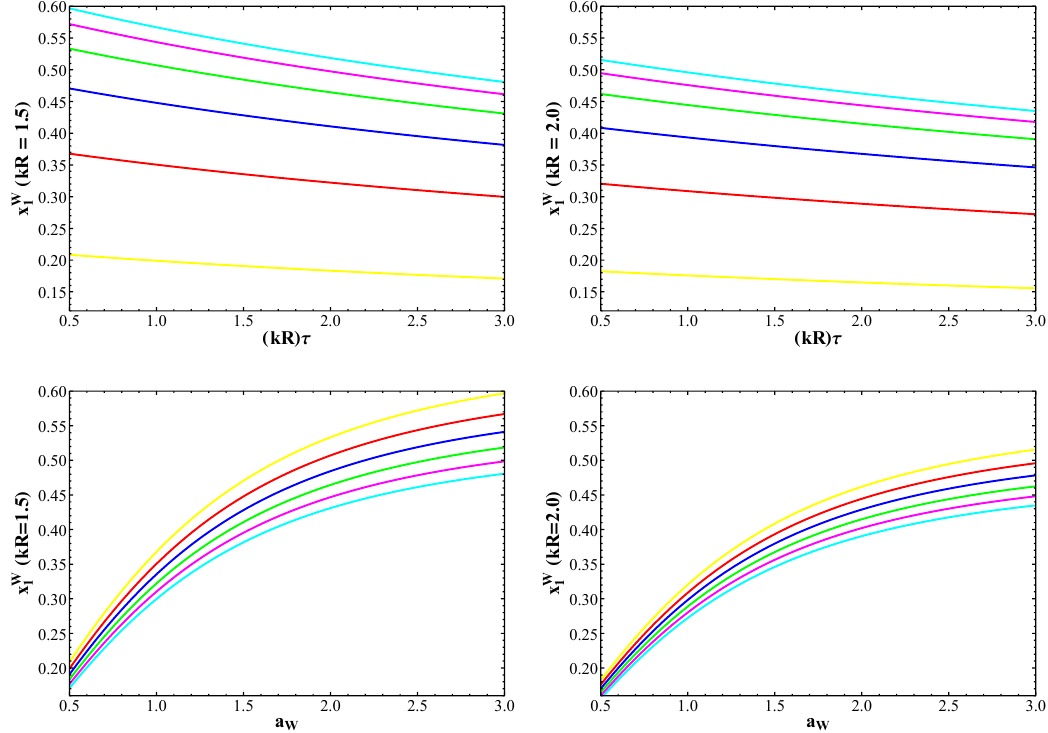
Figure 11 . (Top left) Value of the root x W assuming kR = 1 . 5 as a function of τ for various 1 choices of a W , from bottom to top, a W = 1 / 2 , 1, 3/2, 2, 5/2 and 3, respectively. (Top right) The same as the top left, but assuming kR = 2 . 0 (Bottom left) Value of the root x W assuming as a 1 function of a W for various choices of τ , from top to bottom, ( kR ) τ = 1 / 2 , 1, 3/2, 2, 5/2 and 3, respectively. (Bottom right) The same as the bottom left, but assuming kR = 2 . 0